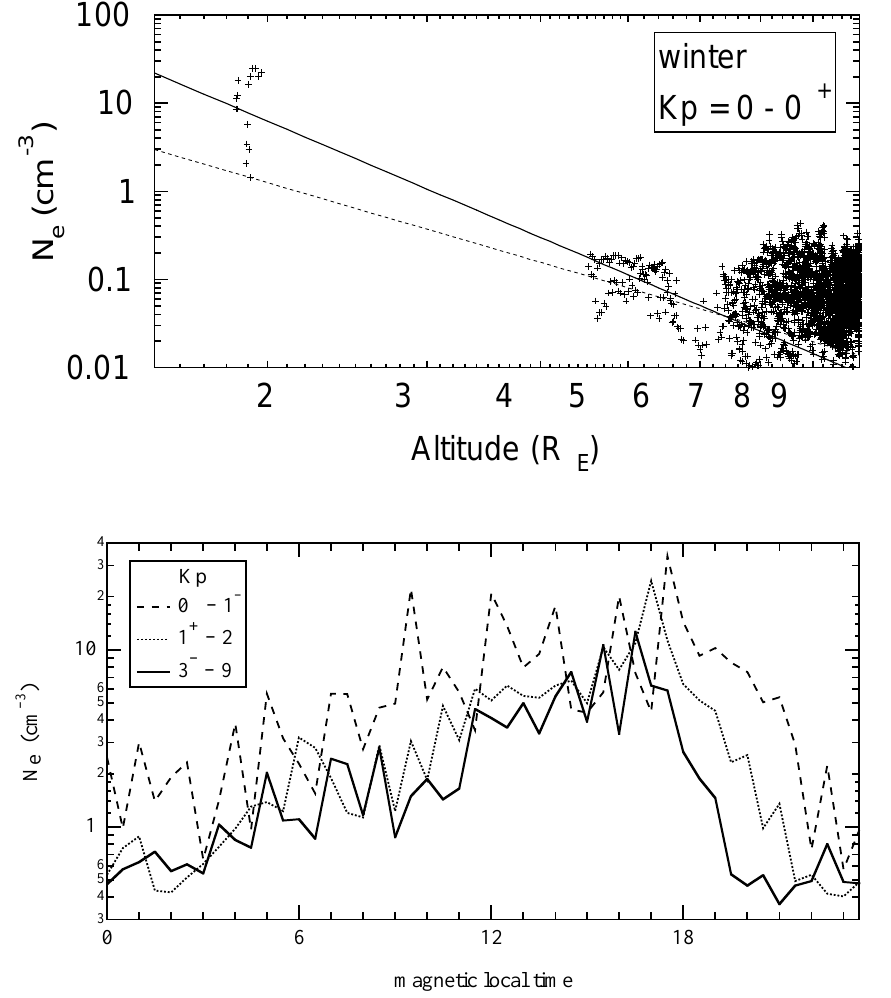
Fig. 7. Average electron densities at L = 6.6 plotted against magnetic local time, based on 45 months of Polar data over the Northern Hemisphere. Densi- ties are binned with the K p index as in Fig.